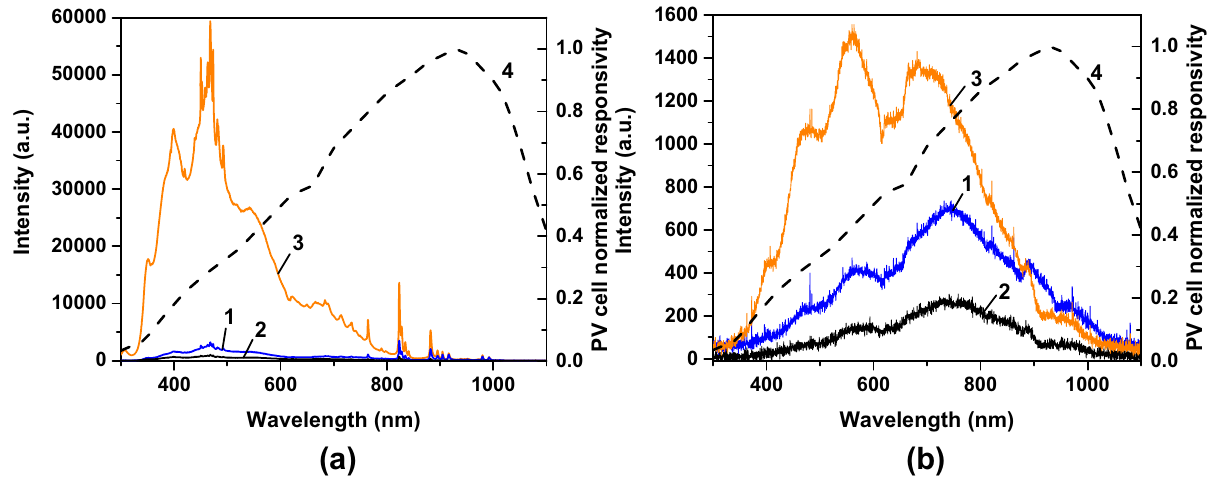
Figure 12: Spectra of the photoluminescence at the edges of the LSC simulator. ( a ) LSC was illuminated with the solar simulator; ( b ) with the light bulb. Spectra 1 correspond to empty LSC ( true spectra of the light sources ) , 2 – LSC fi lled with pure 1 - propanol, 3 – LSC fi lled with the NaY 0.83 F 4 :Yb 0.14 Er 0.03 nanocolloid in 1 - propanol, 4 – normalized responsivity of the PV